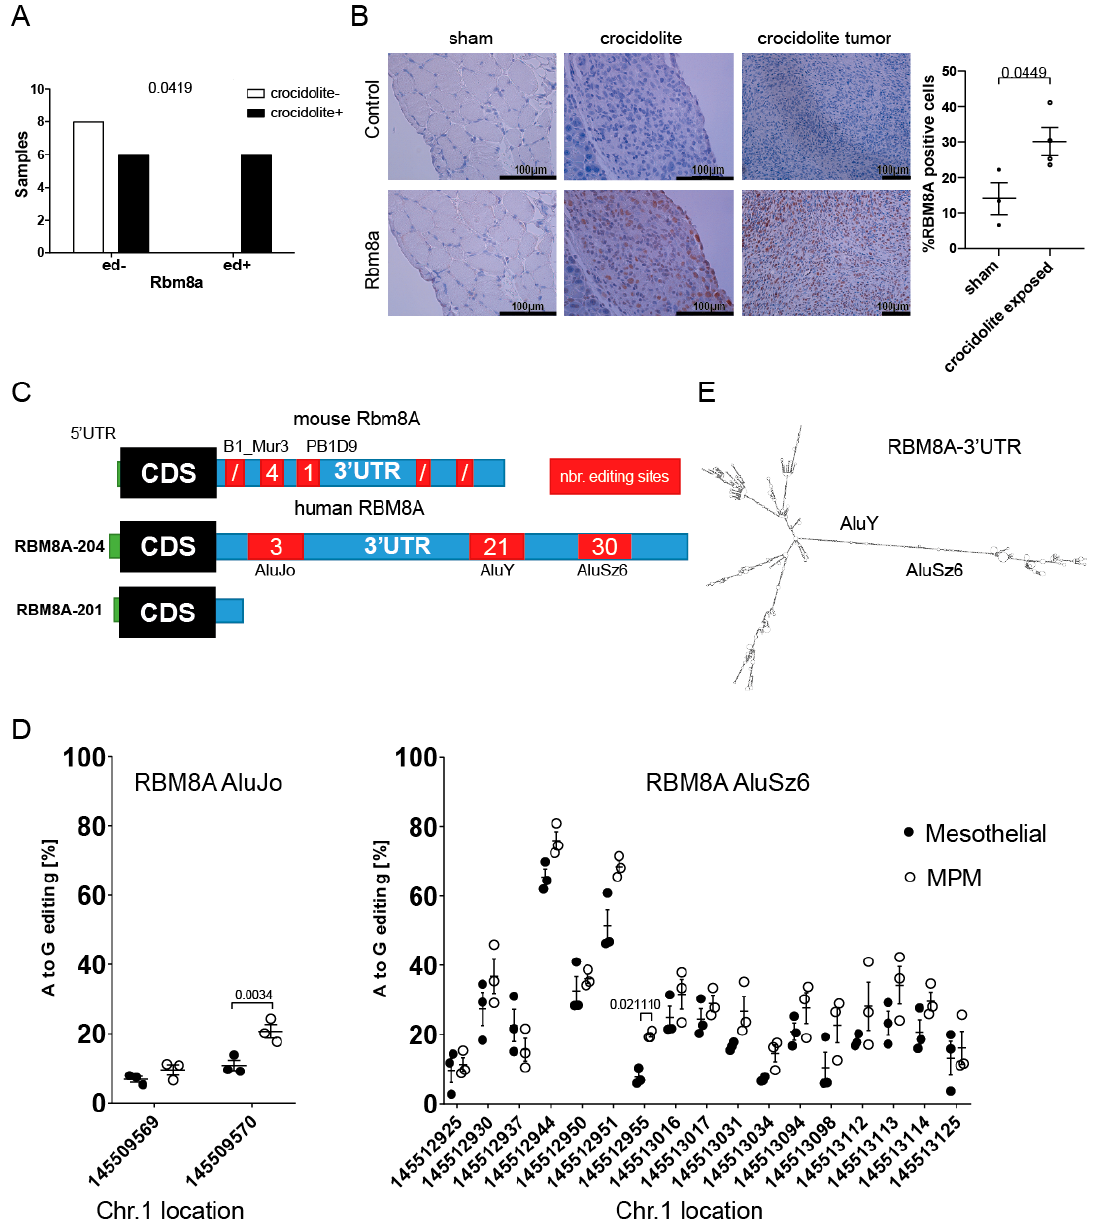
Figure 2. RBM8A 3 ′ UTR is differentially edited in MPM cells compared to normal mesothelial cells. ( A ) Rbm8a mRNA A-to-I editing is significantly increased in tissue from mice experimentally exposed to asbestos. Fisher’s exact test. ( B ) Rbm8a protein nuclear immunostaining is barely detected in some mesothelial cells on the surface of the diaphragm and increases in mesothelioma reactive mesothelium and tumors developing after exposure to asbestos. Unpaired t -test. ( C ) RBM8A transcripts in mice and humans. In mice, only one transcript is present, while in humans, two transcripts with different 3 ′ UTR lengths are present. The location of Alu/SINE elements and number of editing sites described in REDIportal are also indicated. ( D ) In human cells, significantly differently edited sites are located in AluJo and AluSz6. The numbers on the x-axis correspond to the nucleotide position on chromosome 1, human genome version 37, hg19. ANOVA multiple t -test. ( E ) Secondary structure prediction of the 3 ′ UTR sequence using ViennaRNA software confirmed the potential for dsRNA structure of AluY-AluSz6 sequences, where most editing sites are located.